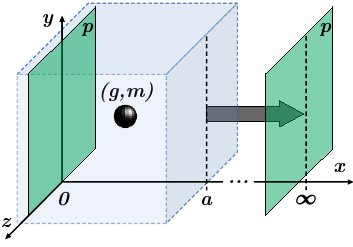
Figure 5 . If we move the plane ( p ) at x = a to infinity everything works like if the plane at x = a did no exist, that is, the resulting configuration is equivalent to a point particle in the presence of a single